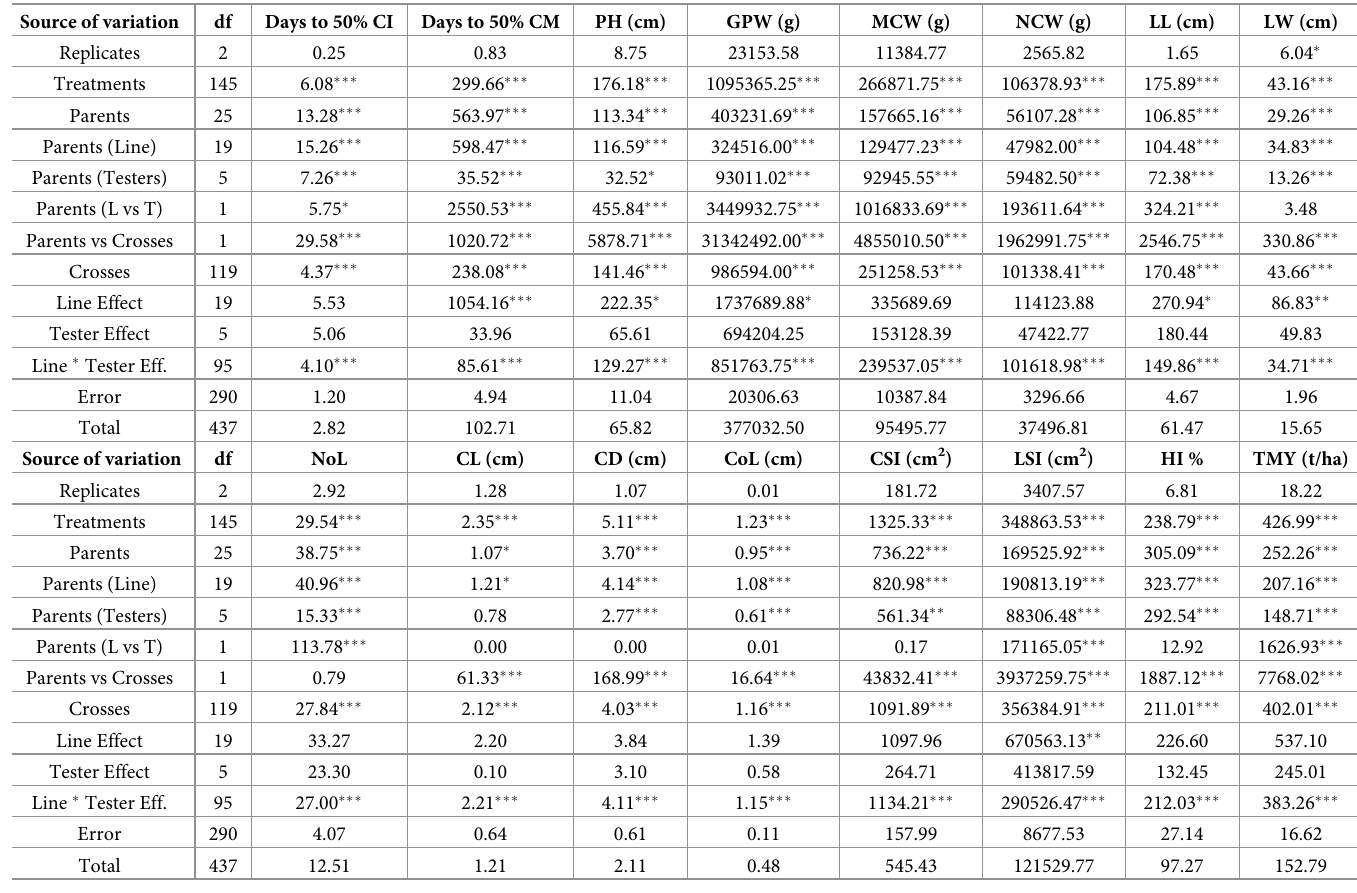
Table 2. Line × Tester Analysis of variance (ANOVA) for combining ability for yield and horticultural traits in